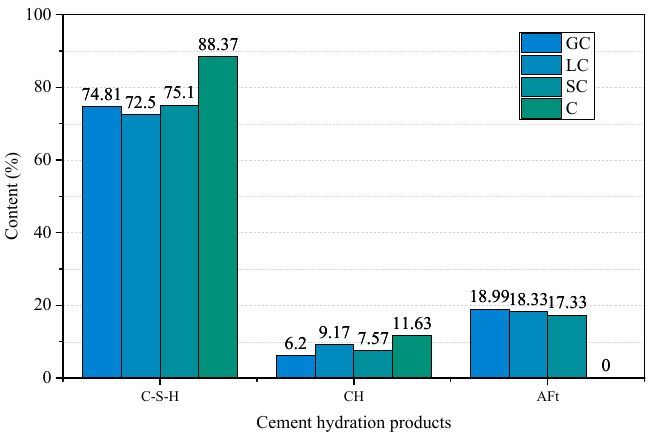
Figure 6. Content of Calcium compounds.